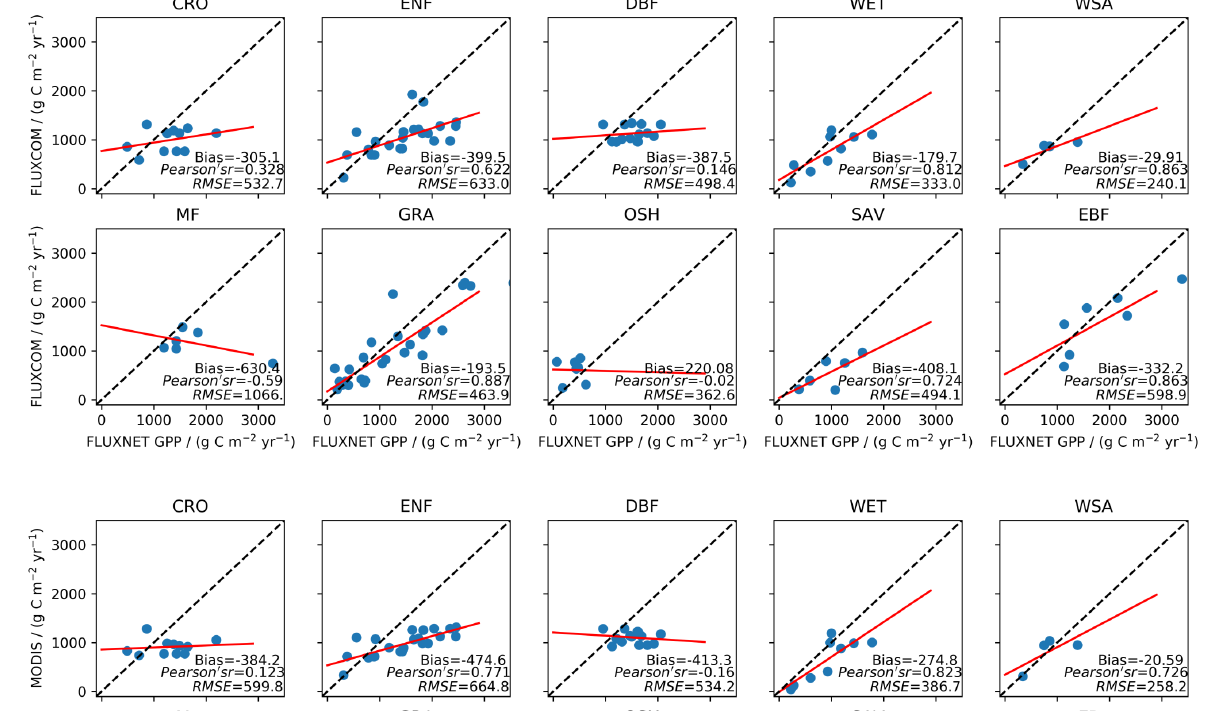
https://doi.org/10.5194/essd-14-1063-2022 Earth Syst. Sci. Data, 14, 1063–1085,